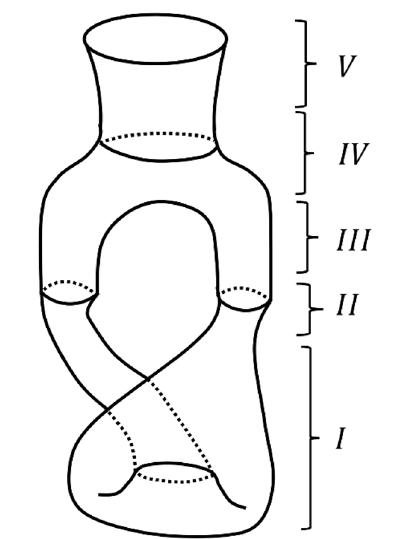
Figure 2 . Region I: perturbatively corrected black brane glued with inversion to the rest of the geometry. Region II: linearized perturbations to vacuum AdS. Region III: perturbatively corrected throat solution. Region IV: the (extremal) two-throat solution. Region V: far from both throats, vacuum AdS with larger